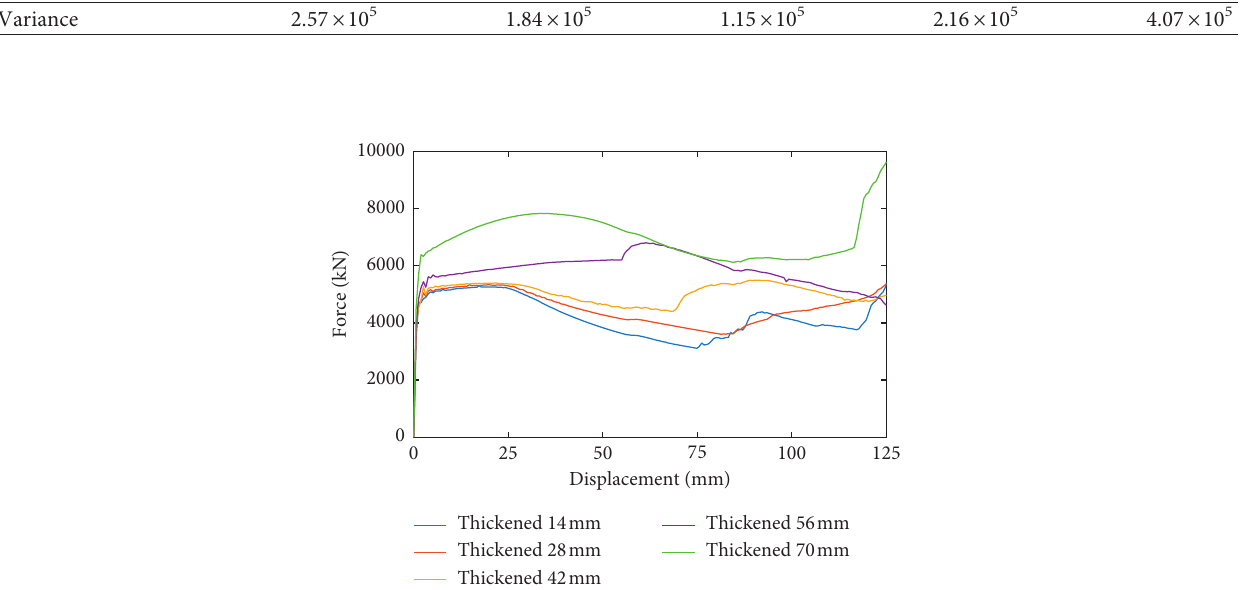
Figure 11: Load-displacement curve of the device under different thickening height conditions.